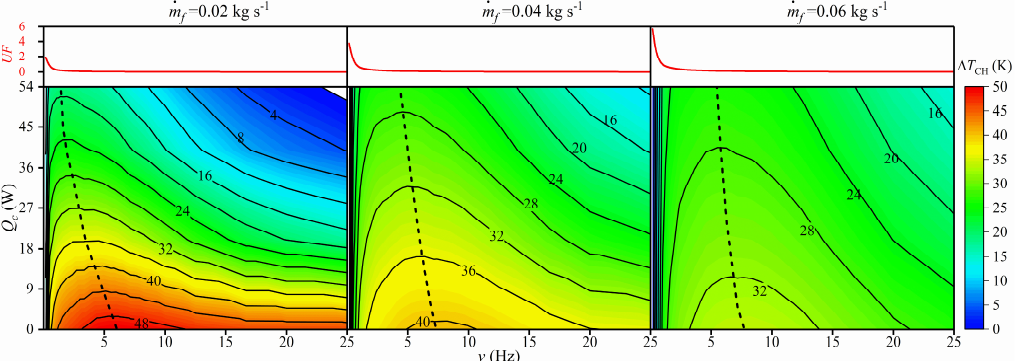
. . Figure 10. Cooling capacity 𝑄 (cid:3030) and temperature difference Δ T CH at different mass flow rates ( H = 1 Q c and temperature difference ∆ T CH at different mass flow rates ( H = 1 T, Figure 10. Cooling capacity . . T, T h = T i = 293 K, solid line: fixed Δ T CH , dashed line: maximum 𝑄 (cid:3030) under the optimal UF ). T h = T i = 293 K, solid line: fixed ∆ T CH , dashed line: maximum Q c under the optimal UF